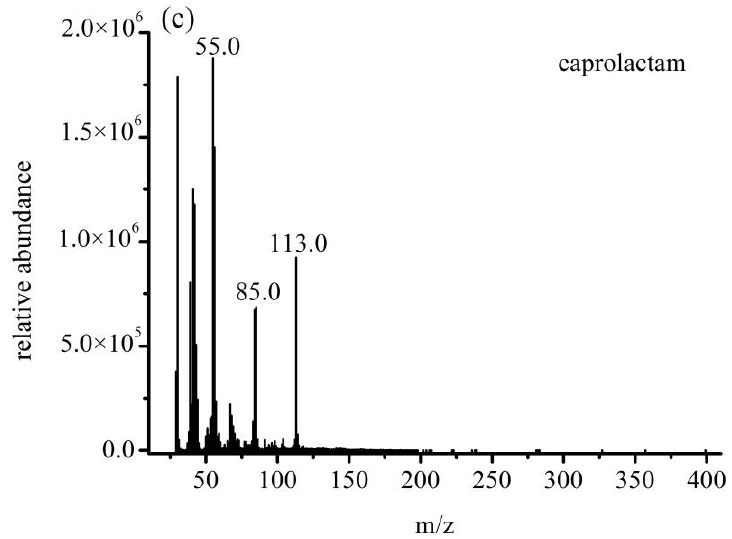
Figure 8. ( a ) Total ion chromatogram (TIC); ( b ) mass spectra of cyclopentanone obtained from Py-GC/MS of PA66; ( c ) mass spectra of caprolactam obtained from Py-GC/MS of PA6. Peaks 1 and 2 in TIC represent cyclopentanone and caprolactam, respectively.